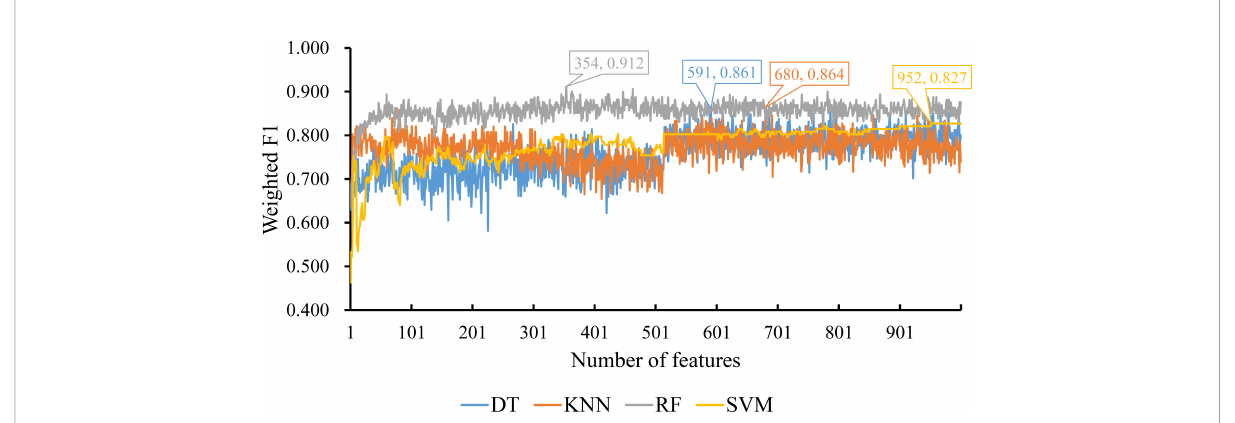
FIGURE 2 IFS curves for displaying the performance of four classi fi cation algorithms on the feature list yielded by MCFS method. The best classi fi ers on different algorithms yield the weight F1 values of 0.861, 0.864, 0.912 and 0.827, respectively, which use top 591, 680, 354 and 952, respectively, features in the